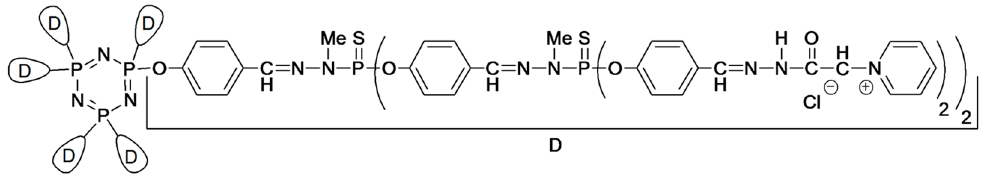
Figure 3. Molecular structure of hydrogelators based on ammonium-functionalized phosphorus-based dendrimers. From [13], Copyright © 2001 by John Wiley & Sons, Inc. Adapted by permission of John Wiley & Sons, Inc.